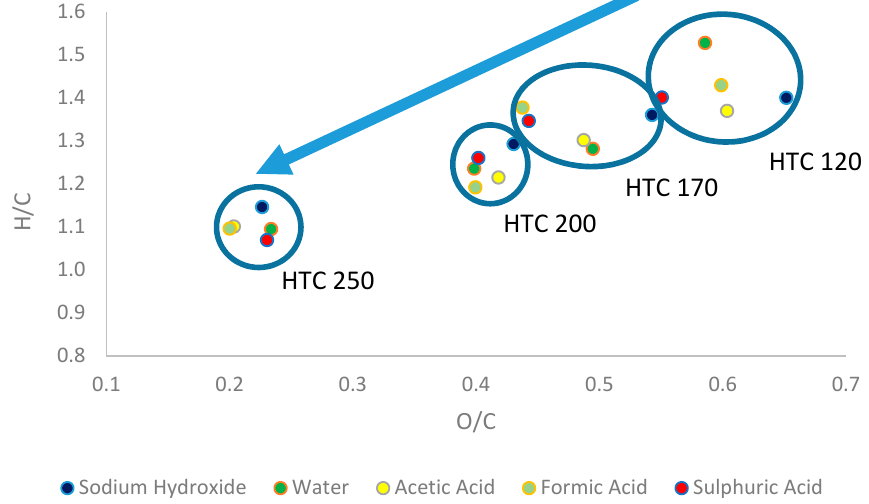
Figure 1. Van Krevelen plot of the bio-coals from di ff erent pH and temperature.